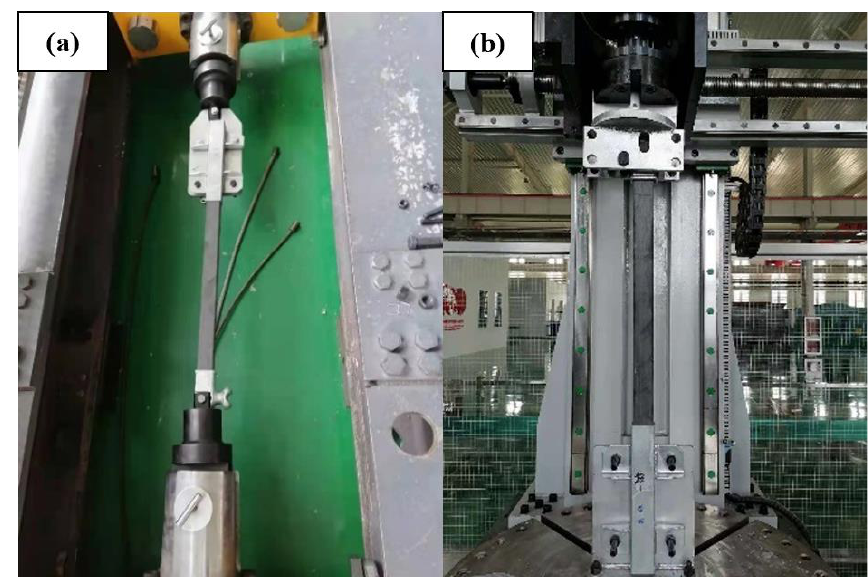
Figure 4. Tensile test ( a ) and bending test ( b ).